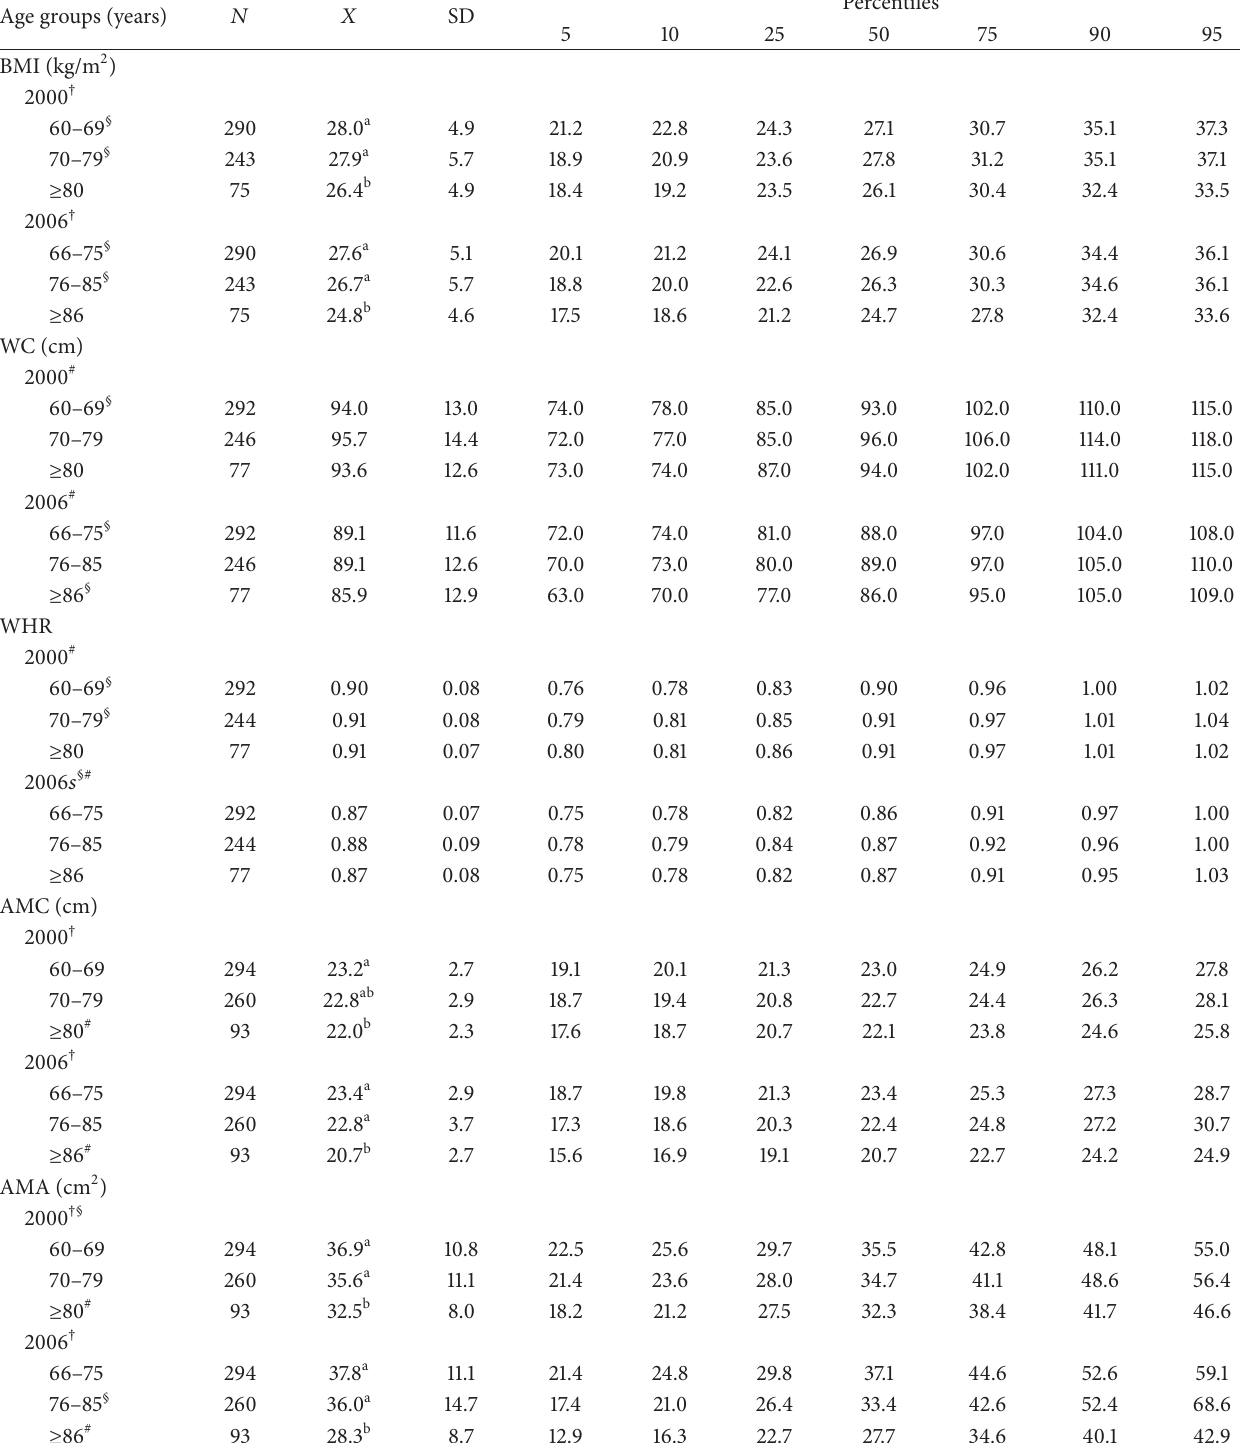
Table 3: Percentile distribution of anthropometric indicators of women by age group (SABE Survey, S˜ao Paulo, Brazil,